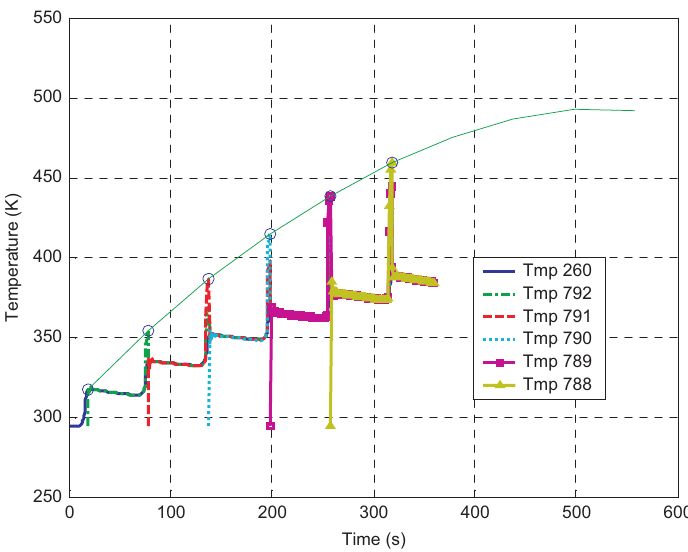
Figure 11 Extrapolations for temperature peaks measured at nodes 260, 792 – 788 along radial direction at the angle of 103.5 ° during 360 s (i.e., six rotations at 1 rpm).